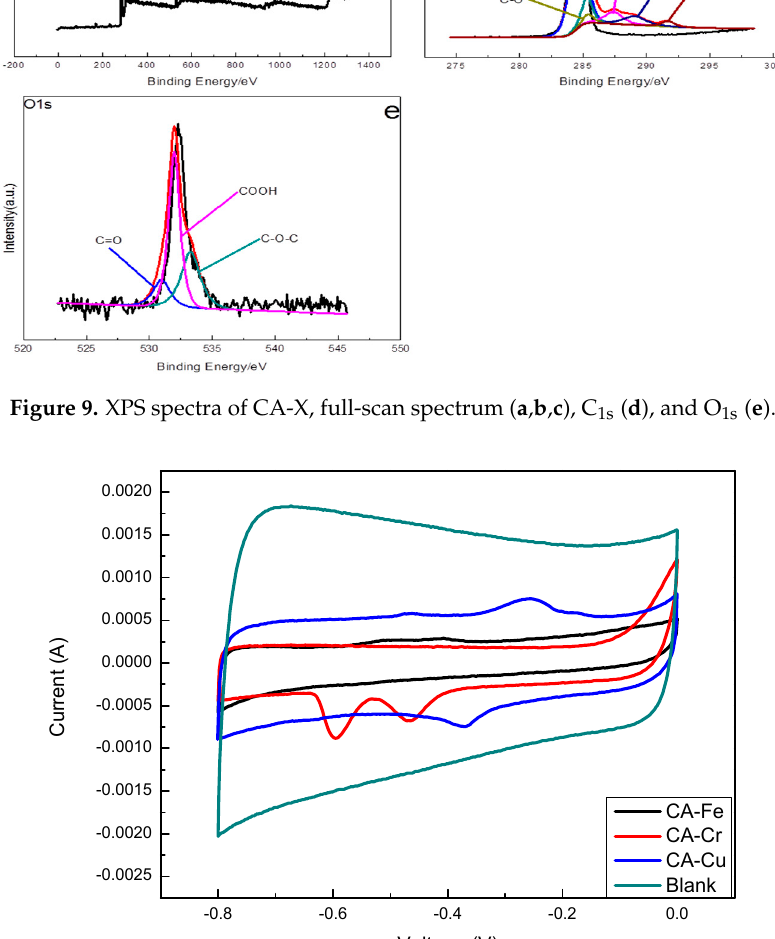
Figure 10. CV curves of different CA-X at a scan rate of 0.5 mV·s − 1.